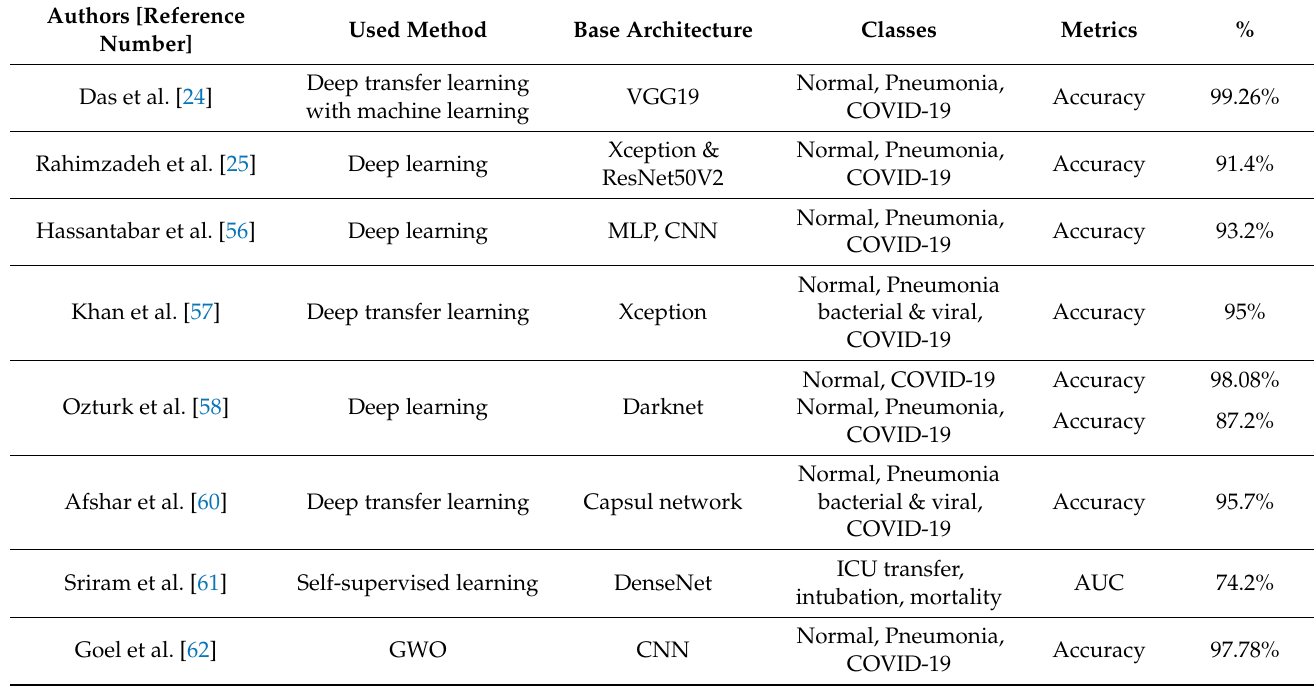
Table 3. Details of previous research works for detecting